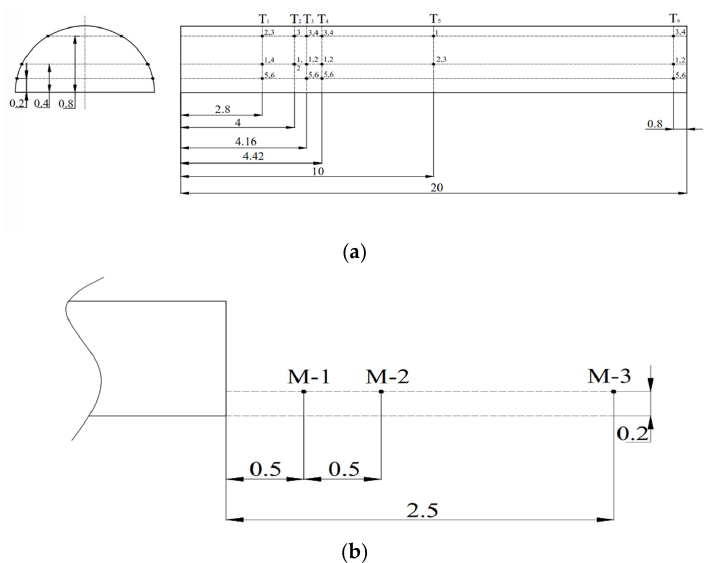
Figure 4. Location of measurement points. ( a ) Location of measurement points in the tunnel. ( b ) Layout of measurement points outside the tunnel.